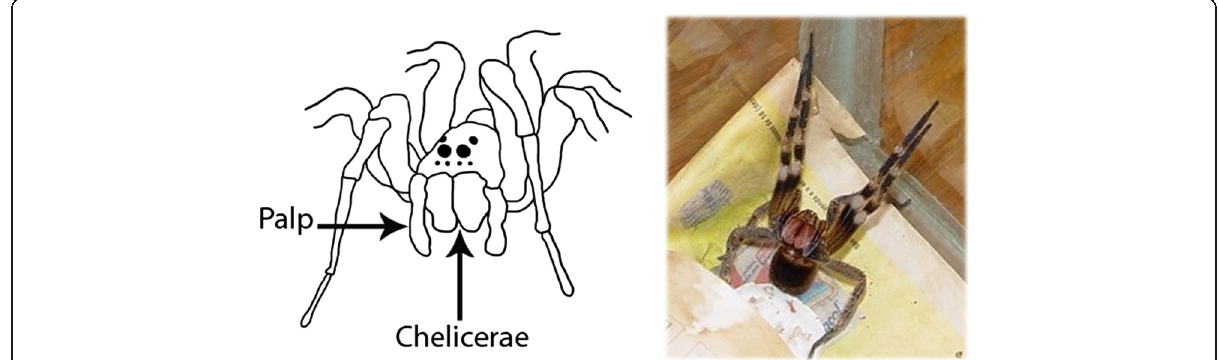
Fig. 3 Photo of a spider and schematic representation of a spider ’ s chelicerae. Chelicerae are associated with venom glands, which are responsible for the production and storage of venom. The chelicerae are also used to trap and kill the prey